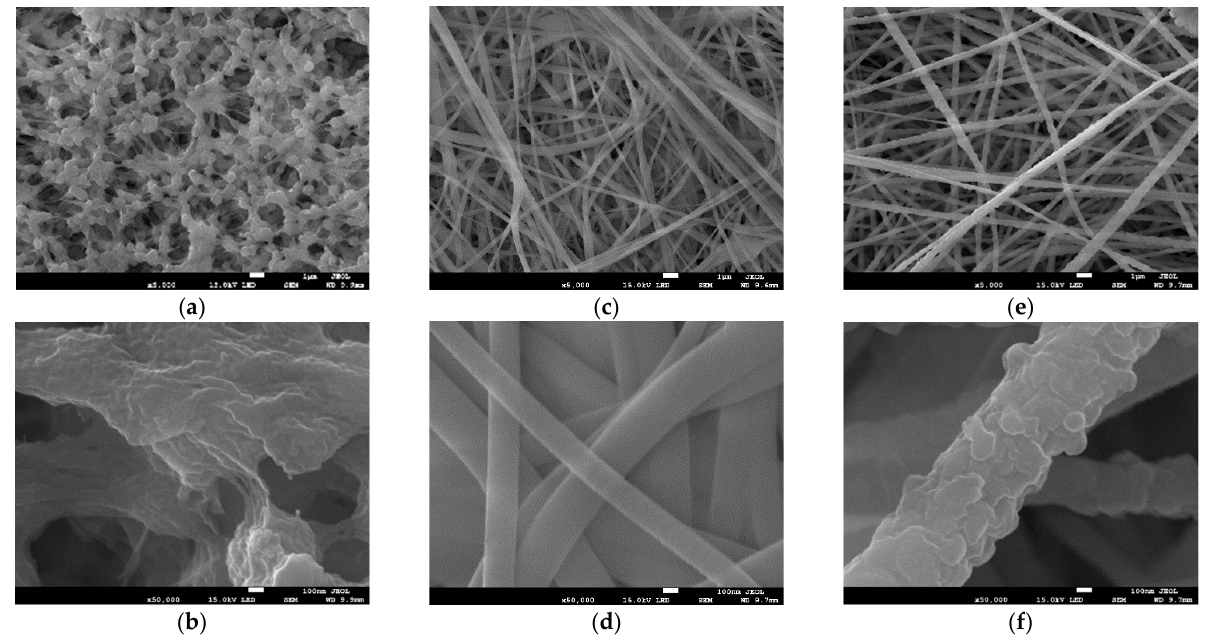
Figure 3. Scanning electron micrograph of ( a ) and ( b ) PVDF-H, ( c ) and ( d ) PVDF-E, ( e ) and ( f ) PVDF-O membrane. Table 5. The content of each element on the surface of PVDF-H, PVDF-E and PVDF-O membranes tested by EDS.